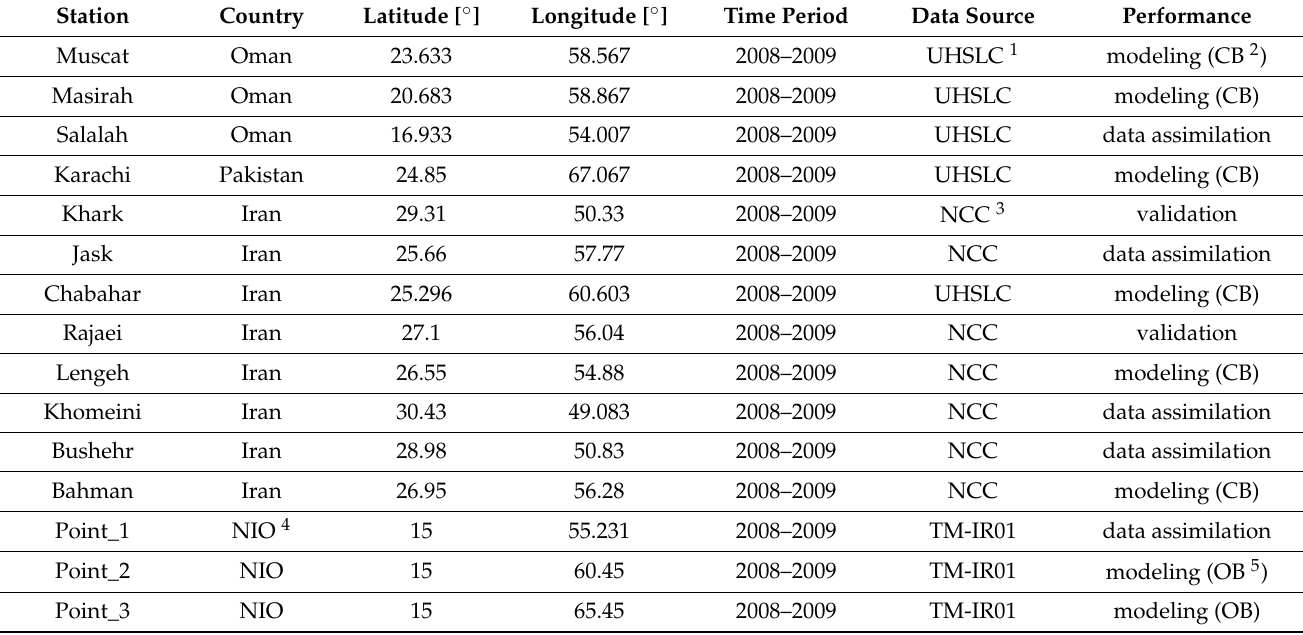
Table 1. Specifications of tide gauge stations.